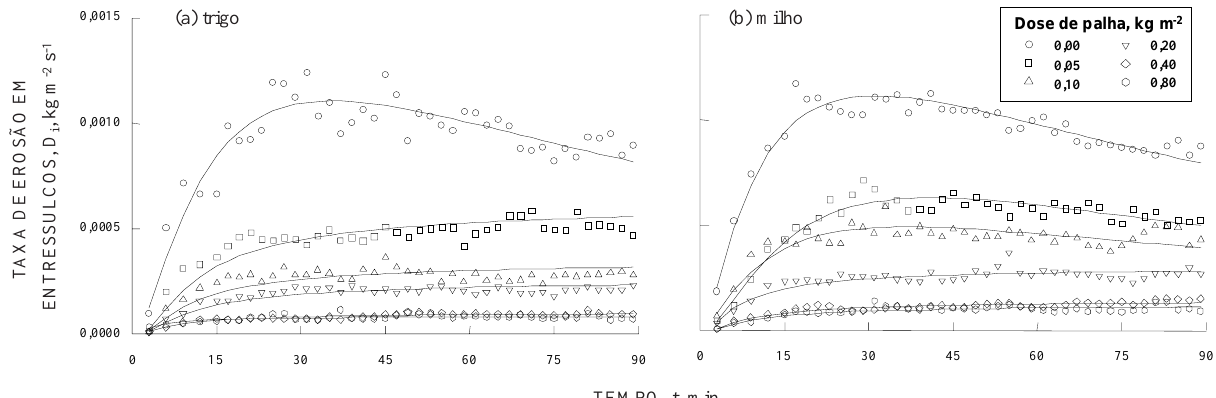
Figura 2. Taxas de erosão em entressulcos, em função do tempo, para diferentes quantidades de palha distribuídas sobre o solo. (a) palha de trigo e (b) palha de milho.